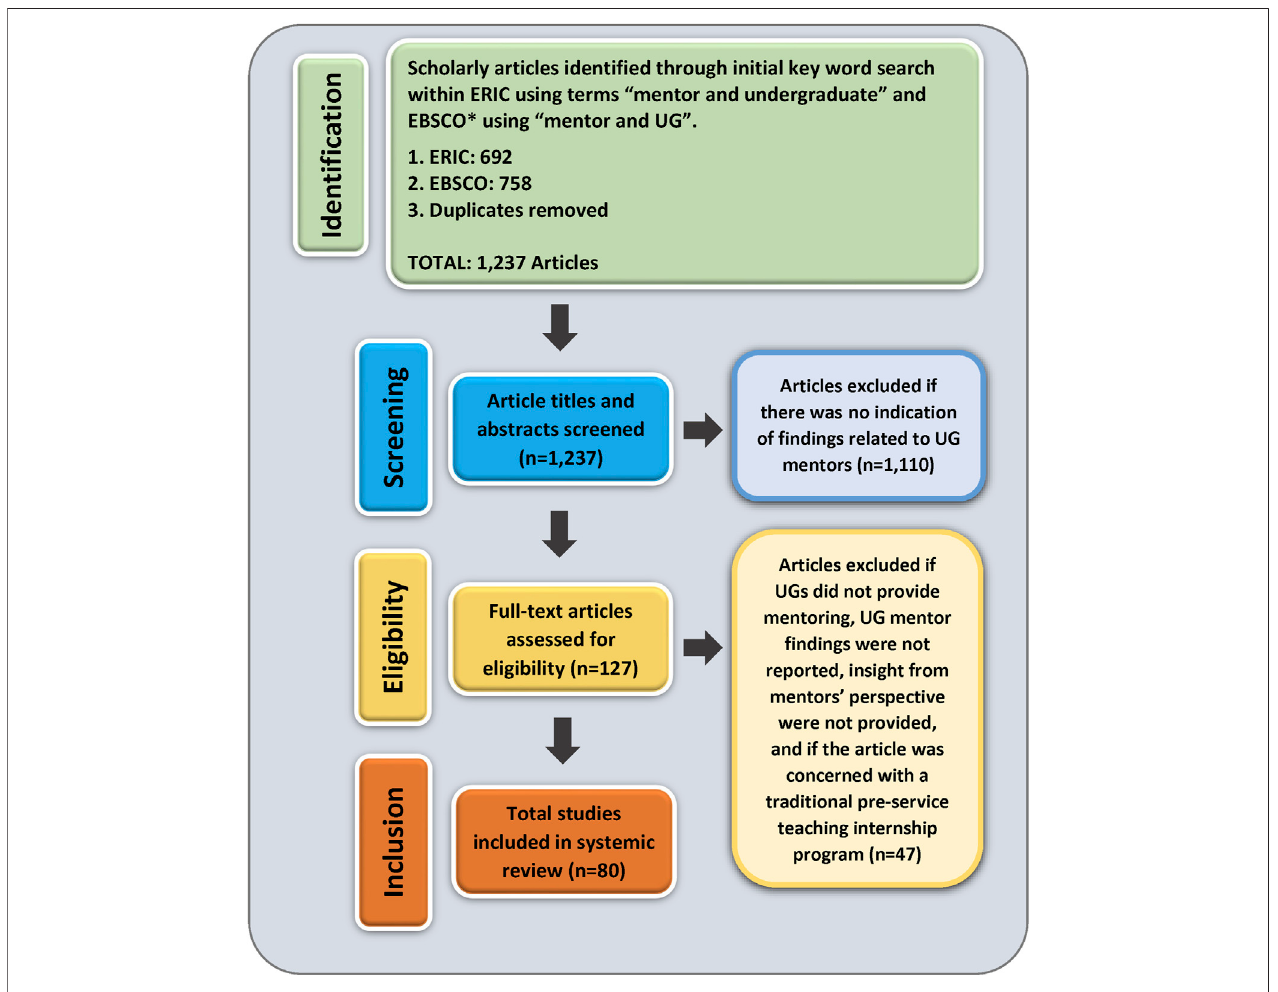
FIGURE 1 | Prisma fl ow diagram (Moher et al., 2009) for record identi fi cation, inclusion, and exclusion. *Databases included within EBSCO search: Academic Search Complete, Education Source, E-Journals, PsycARTICLES, PsychINFO, Psychology and Behavioral Sciences Collection, and Teacher Reference Center.